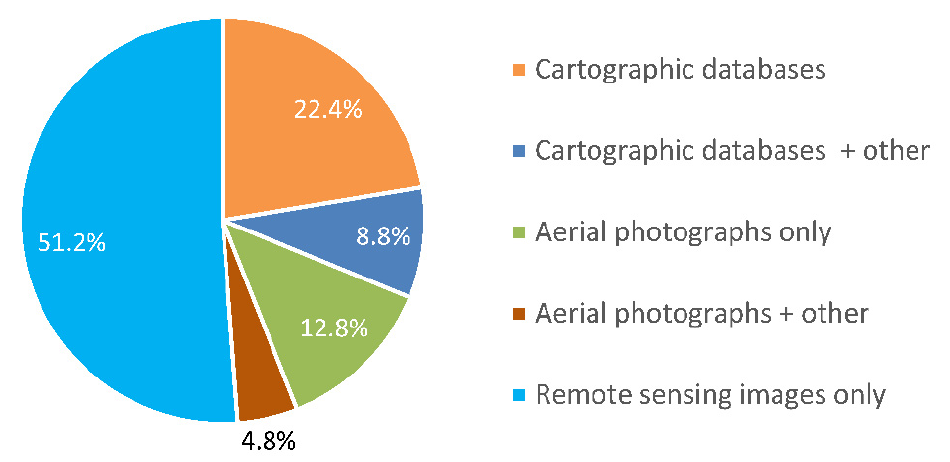
Figure 8. EO data sources from all papers. Source: own elaboration. The temporal extent analysis showed that long-term analysis (more than 30 years) was the most usual situation, accounting for more than 80 papers (34.8%), followed by the group between 16 and 20 years (16.4), equivalent to the medium term. However, from the total number of works that used methods for identifying and classifying LUC with RS, 8.0% did not explain the methods used, whereas, in 14.4%, the method used was photoint- erpretation of satellite images. The rest (77.6%) carried out automatic classifications, with diverse options. The supervised methods were the most common, as they were used in 45.6% of the total. The most common supervised classification was maximum likelihood (equivalent to 71.9% of all the supervised classifiers) (Figure 9), whereas the second most common method for automatic classification was the object-based classifier (OBIA) (11.2% of the total).